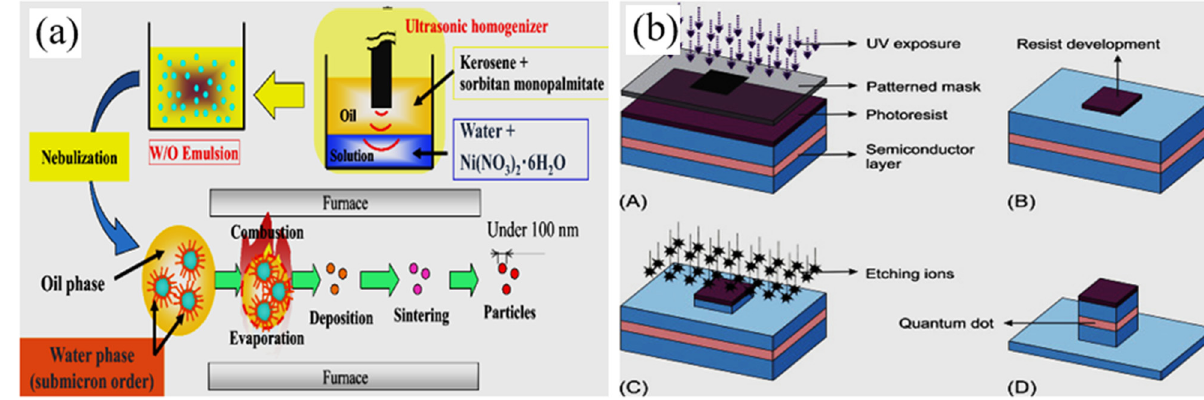
Figure 1: Illustration of ( a ) thermal decomposition [ 37 ] and ( b ) nanolithography technique [ 39 ] of NiNPs